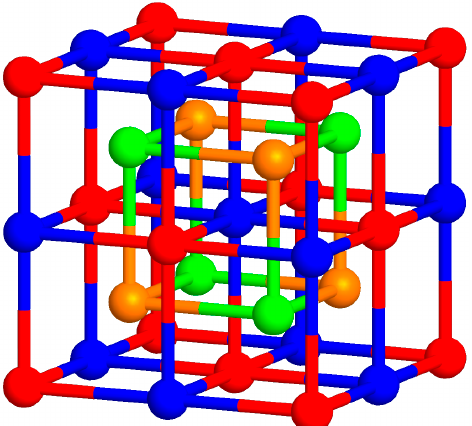
Figure 1. Unit cell of Heusler Fe 2 Mn(Si, Al) alloy. The sites are denoted by A (red), B (orange), C (blue), and D (green).